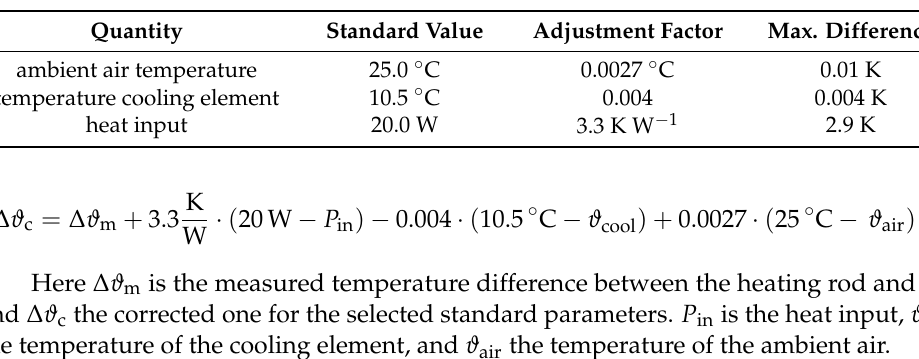
Table 3. Standard values, adjustment factors, and maximum temperature difference caused by a variation in the measured range for the varying parameters according to Equation (3).